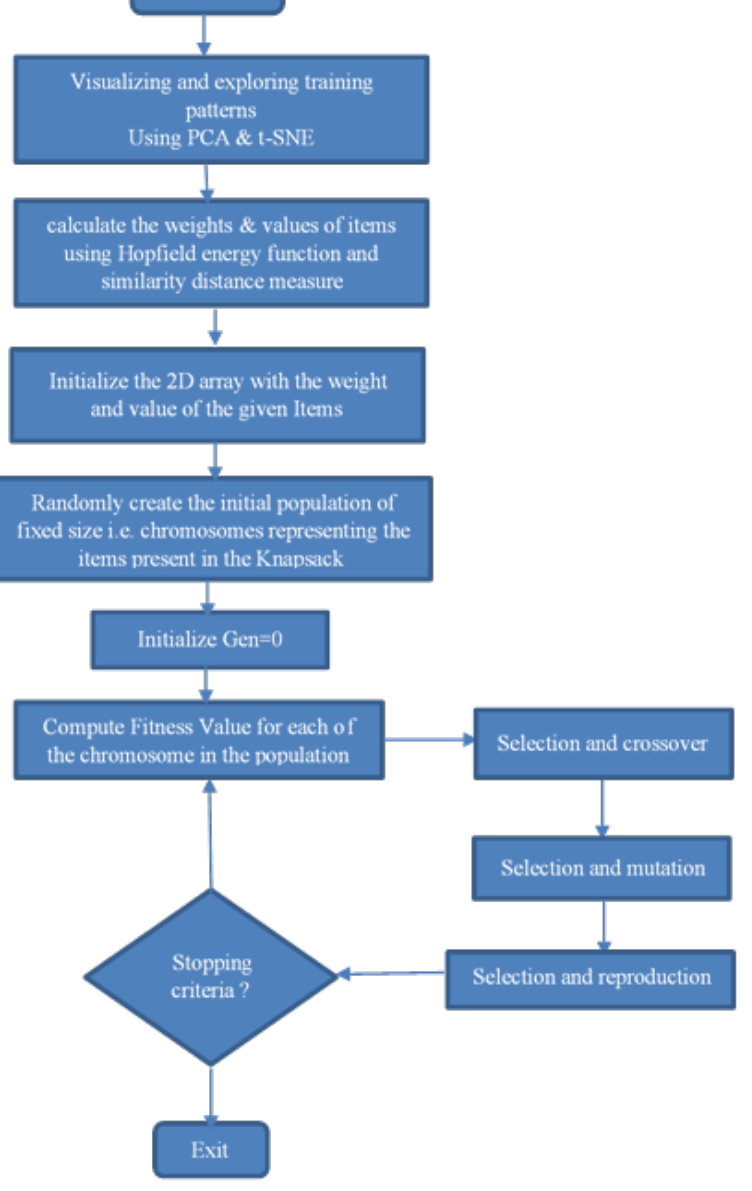
Figure 3. Flowchart of the proposed approach